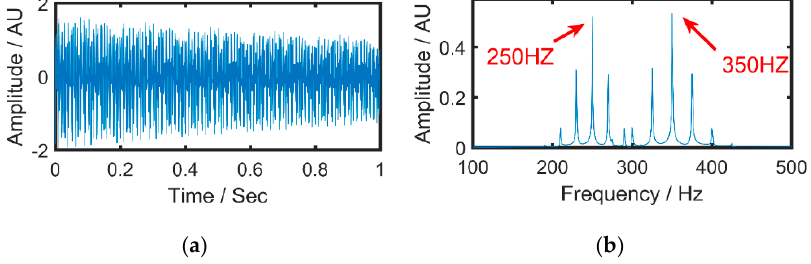
Figure 6. Simulation signal (( a ) time-domain diagram, ( b ) frequency domain diagram).